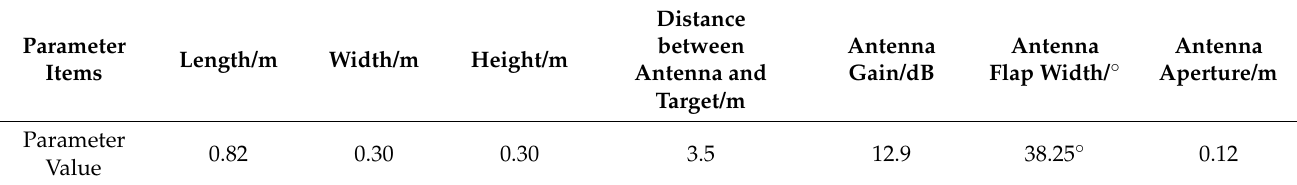
Table 3. In-orbit parameters of TX-1 stealthy